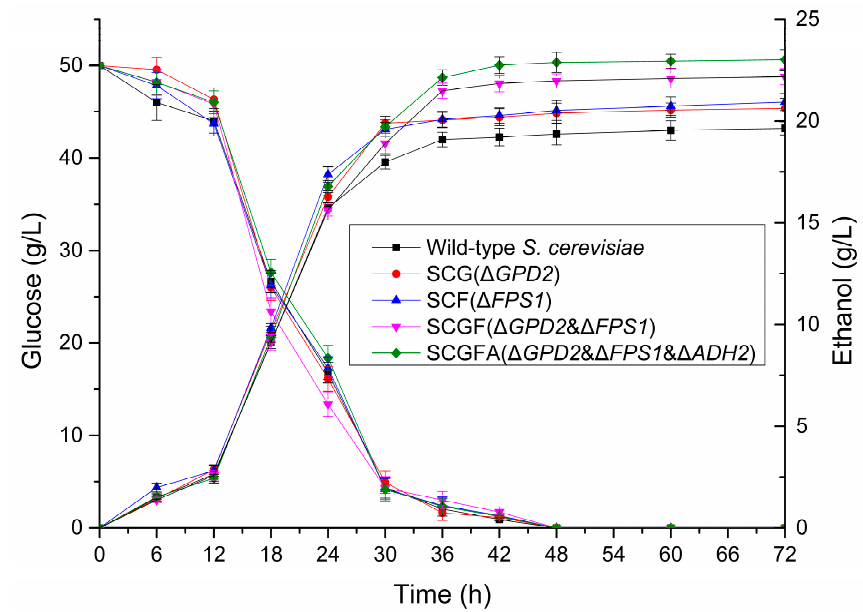
Figure 5. Glucose consumption and ethanol production of engineered S. cerevisiae .